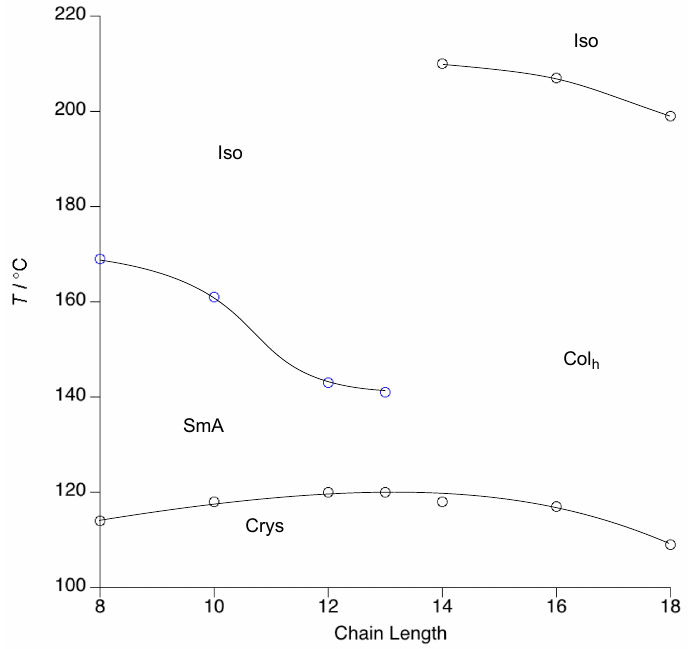
Figure 10. Phase diagram for 1 - n (reproduced from reference [15] with permission from the Royal Society of Chemistry).